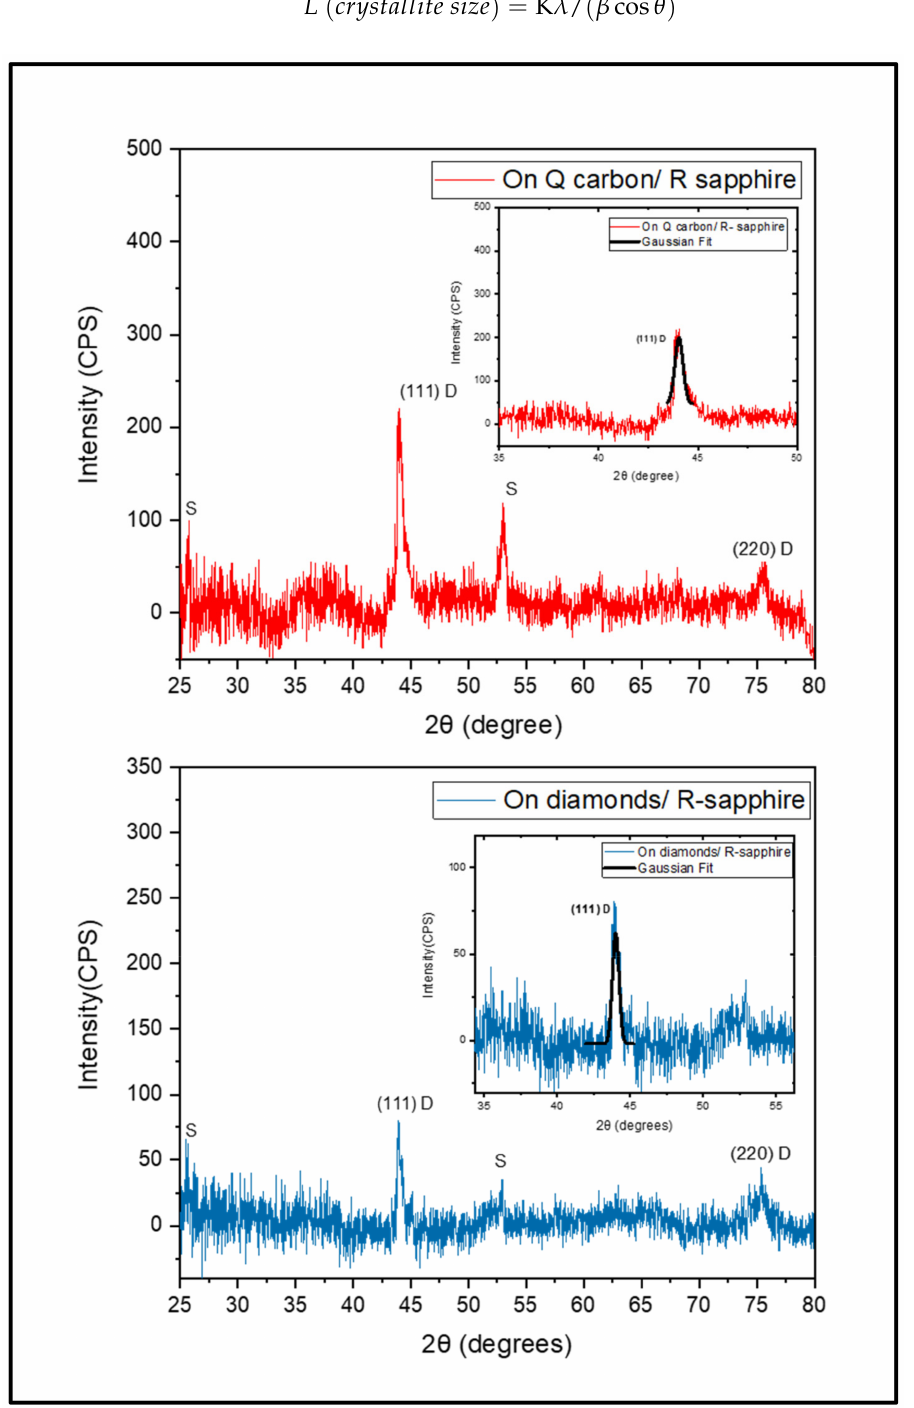
Figure 9. X-ray diffraction pattern by grazing incidence obtained from different regions in the diamond film grown using Q-carbon and diamond